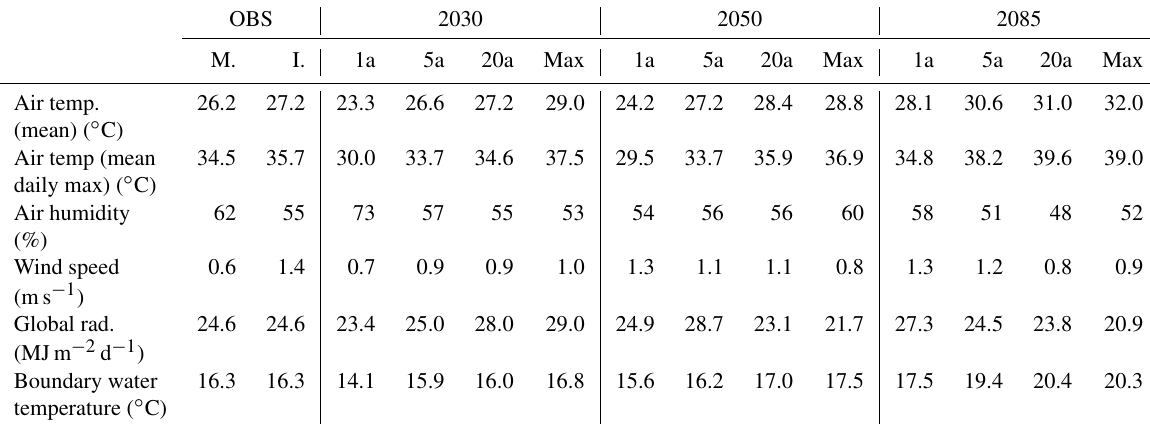
Table 2. Mean and daily maximum air temperatures, air humidity, wind speed, global radiation at the reference station and water temperature at the upstream model boundary averaged for the selected 5-day heat episodes in 2013 and the 1a, 5a, 20a and Max events of the climate periods centred on 2030, 2050 and 2085. For 2013 (OBS), measured values of the reference station 2m above the river (M.) and interpolated measurement data from the INCA (I.) data set are